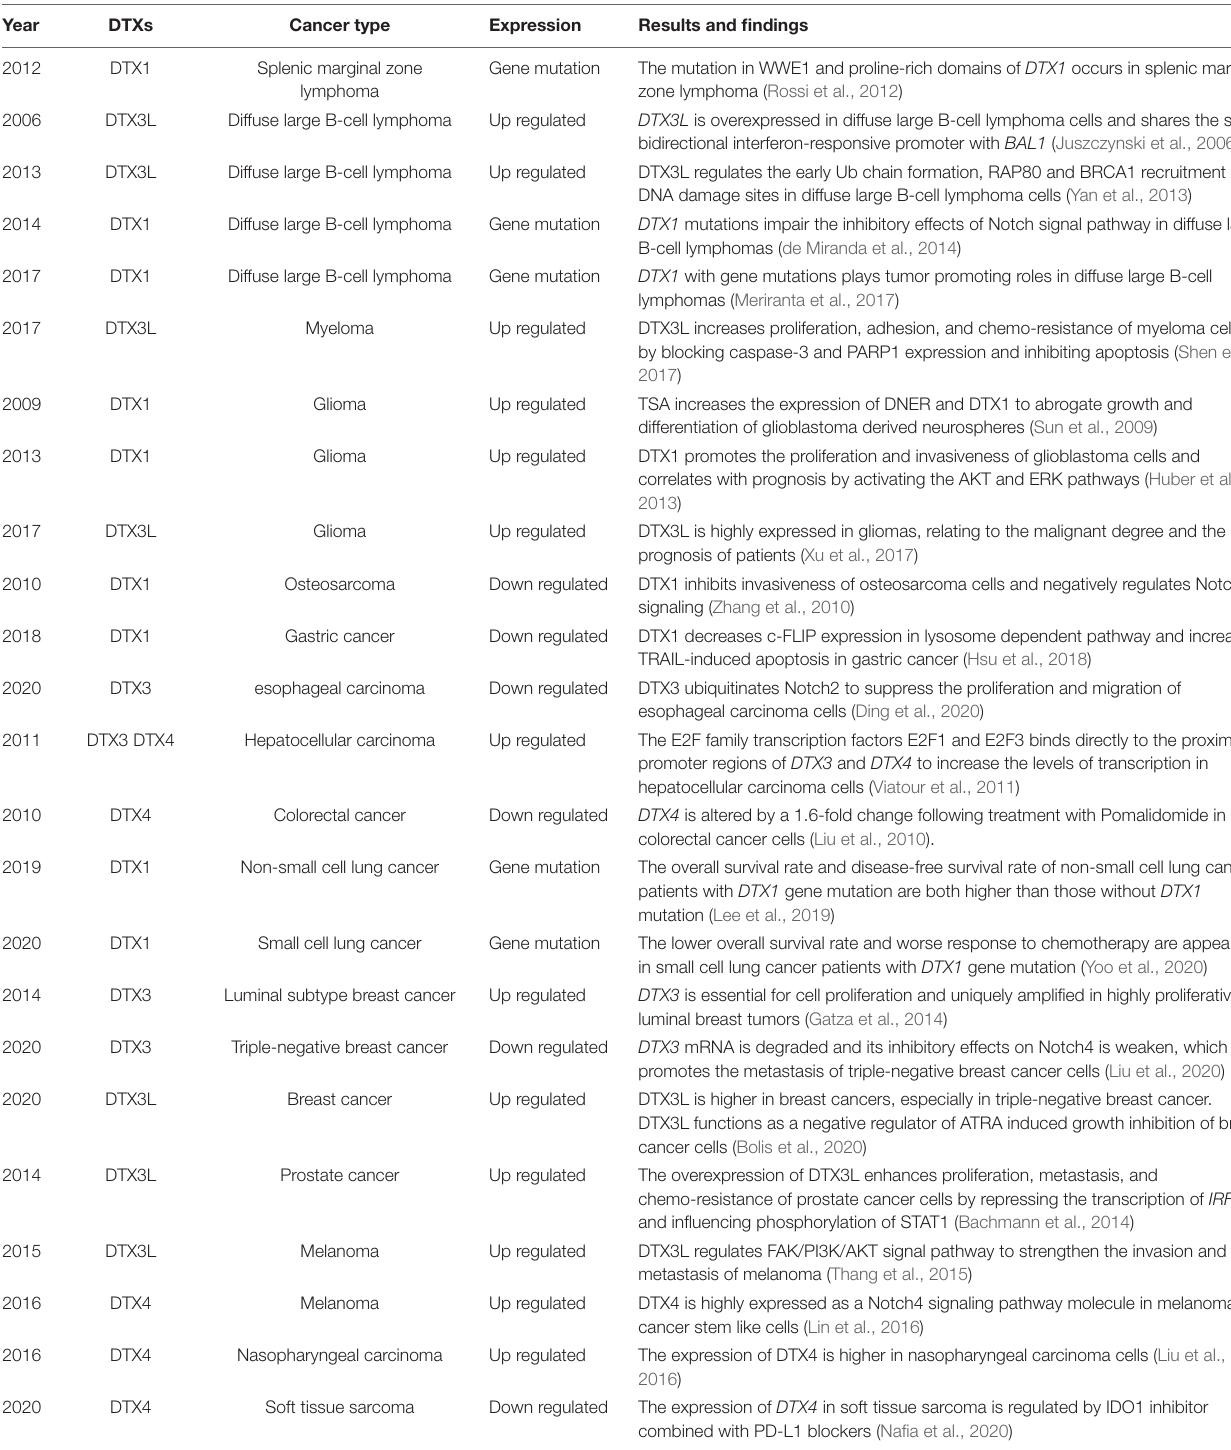
TABLE 2 | Overview of studies with described altered levels, functions, and mechanisms of DTX family members in different cancer types. Expression Results and